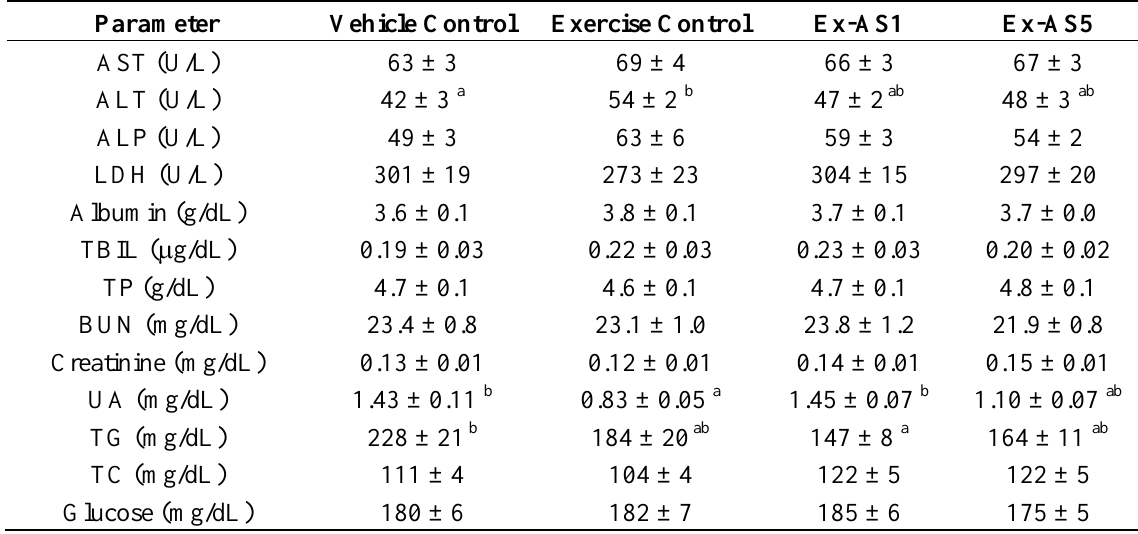
Data are mean ± SEM for 10 mice in each group. Data in the same line with different letters (a and b) significantly differ at p < 0.05 by one-way ANOVA. AST, aspartate aminotransferase; ALT, alanine aminotransferase; ALP, alkaline phosphatase; LDH, lactate dehydrogenase; TBIL, total bilirubin; TP, total protein; BUN, blood urea nitrogen; UA, uric acid; TG, triacylglycerol; TC, total